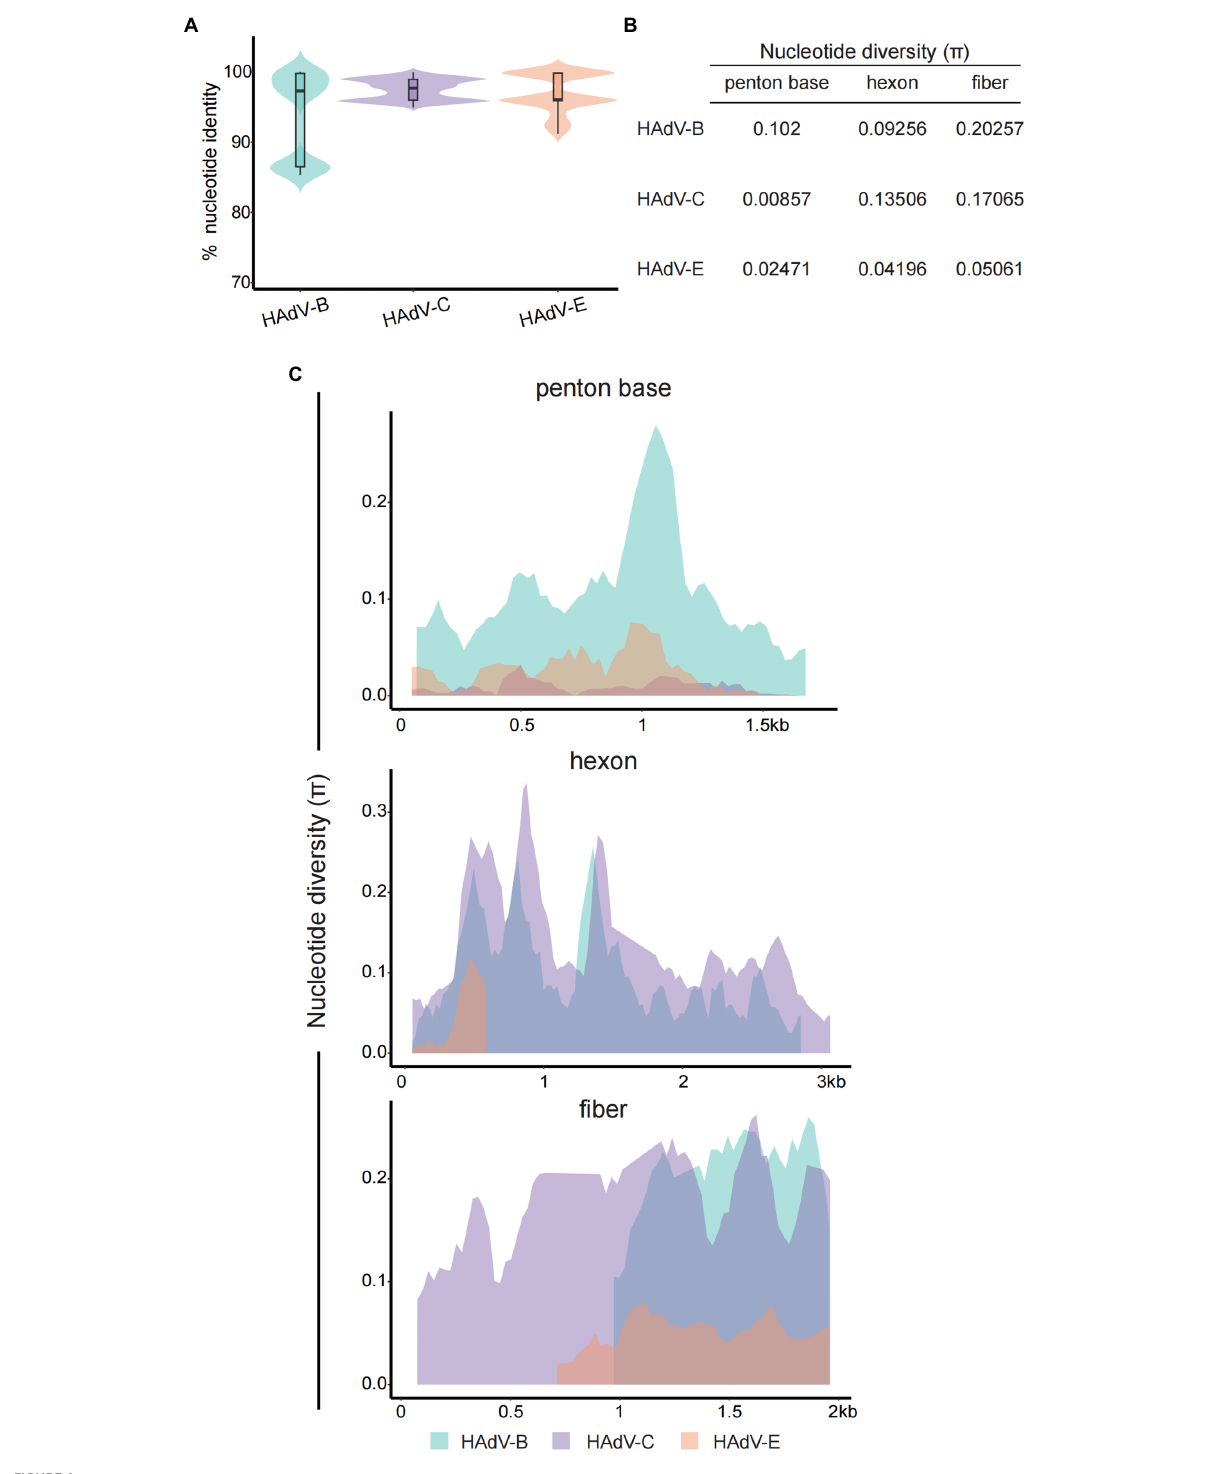
FIGURE 4 Nucleotide sequence identity and diversity for HAdV-B, C, and E. (A) Violin plot for percent nucleotide identity of different HAdV genotypes at the whole genome level. The box-plot in each violin displays the median, lower, and upper quartiles. The straight lines outside the box show the minimum and maximum values. (B) Average nucleotide diversity ( π ) statistics of the three major capsid genes between different HAdV genotypes. (C) Sliding window plot of the nucleotide diversity ( π ) per site (excluding gaps) showing the level of genetic diversity among the penton , hexon , and fiber genes of different HAdV genotypes. The π values were calculated on DnaSP v6 with 100 bp window length and 25 bp step size. HAdV-B and-E had shorter fiber genes than HAdV-C, and the aligning data was displayed